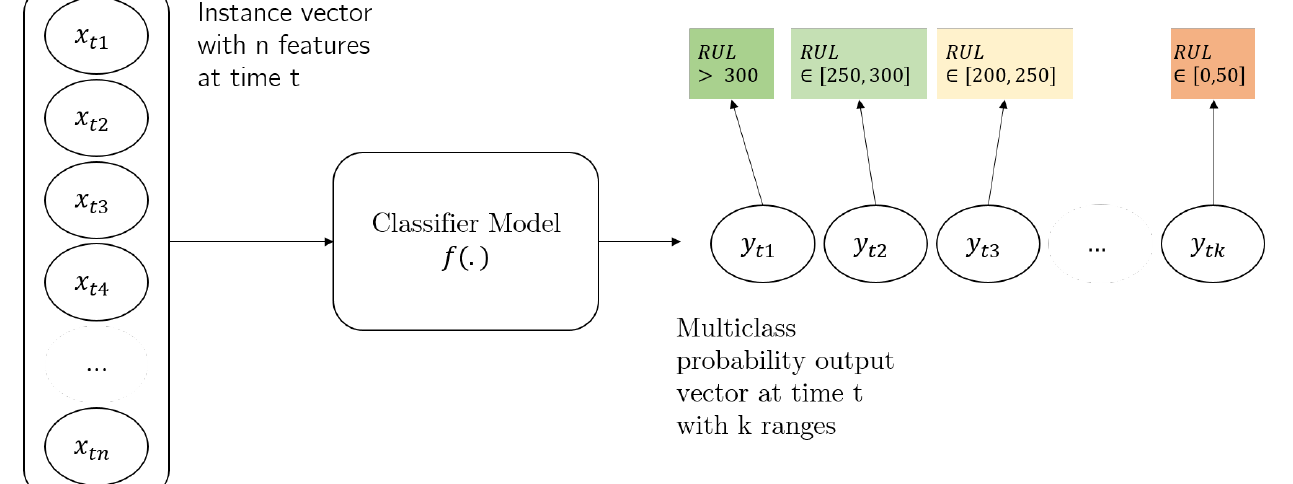
Figure 3. General proposed framework. The classifier model receives as input a set of feature values and computes an output vector of probabilities that correspond to the likelihood of the system being in different health stages.